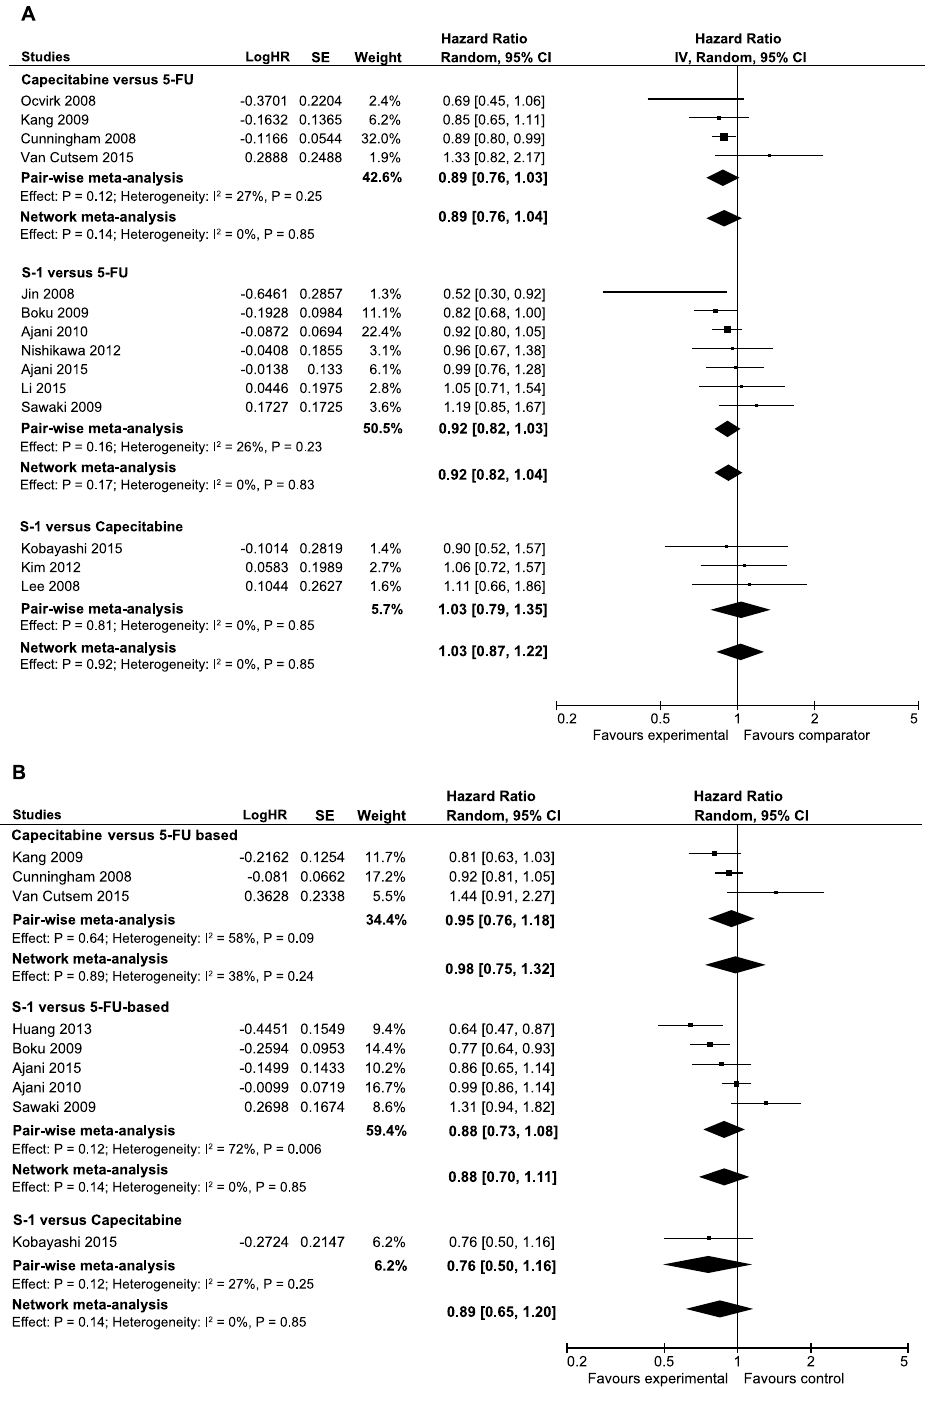
mucositis compared to regimens including oral fluoropyrimidines. On the other hand, S-1 based regimens were associated with less clinically relevant adverse events compared to regimens including conventional 5-FU, such as less febrile neutropenia and toxicity related deaths in Western patients and less grade 1-2 hand-foot syndrome compared to regimens including capecitabine in Asian patients. Although S-1 regimens also showed a lower rate of grade 3-4 hand-foot syndrome compared to capecitabine regimens (0% versus 3%), this difference did not reach statistical significance. From clinical perspective, occurrence of hand-foot syndrome is a very relevant